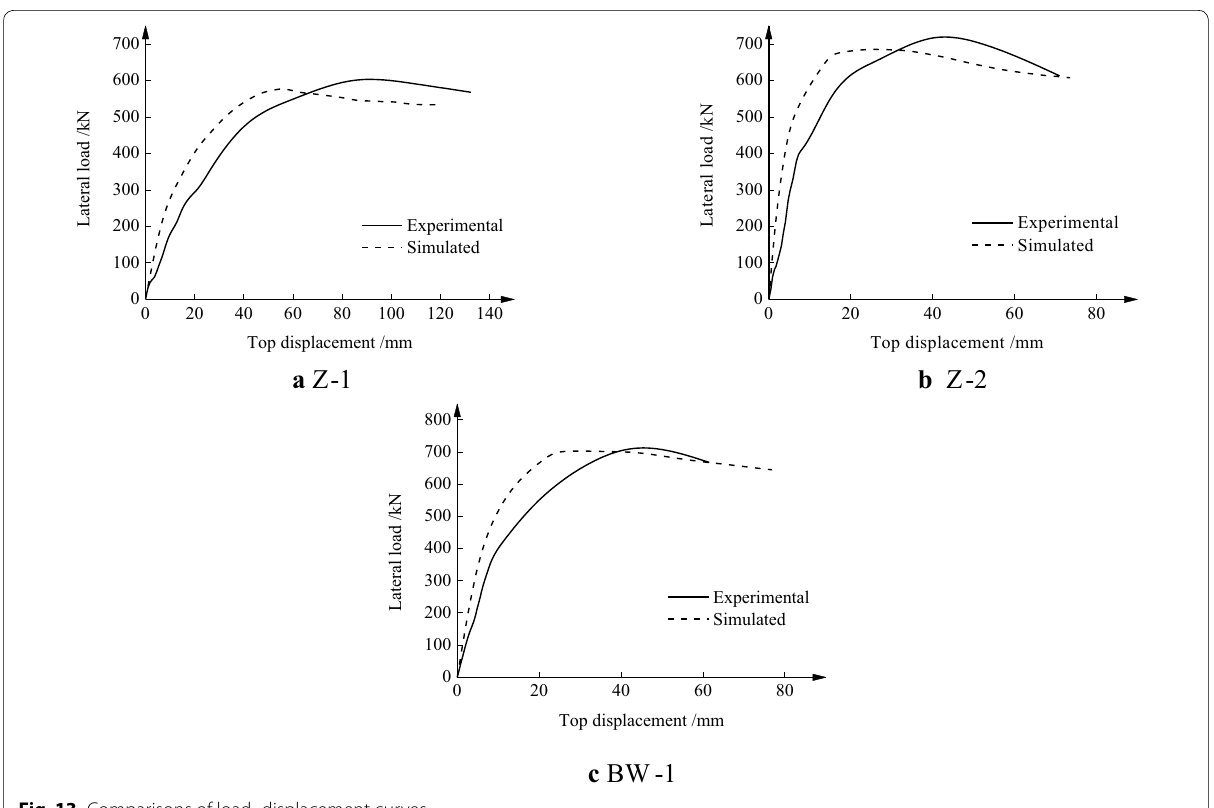
Fig. 13 Comparisons of load–displacement curves.